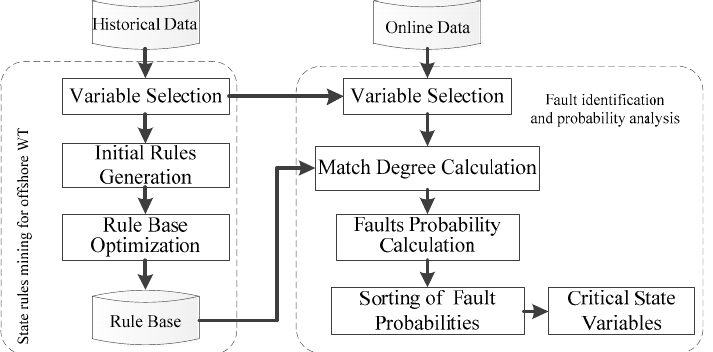
Figure 5. Flow chart of fault identification and probability analysis for offshore WTs.